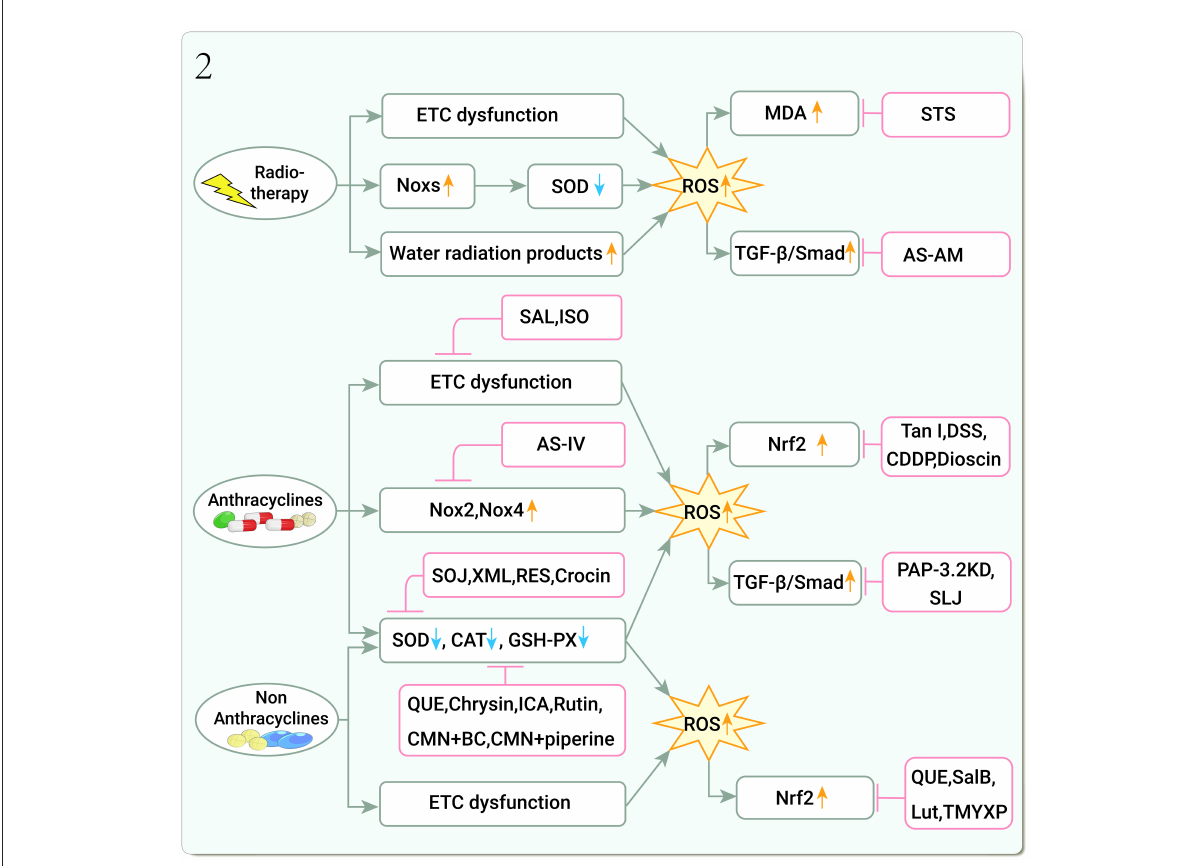
FIGURE2 Traditional Chinese medicine alleviates cardiotoxicity associated with chemoradiotherapy by inhibiting oxidative stress (Noxs, NADPH oxidases; SOD, Superoxide dismutase; CAT, Catalase; GSH-PX, Glutathione peroxidase; ROS, Reactive oxygen species; MDA, Malondialdehyde; TGF- β , Transforming growth factor- β ; Smad, Small Mothers Against Decapentaplegic; Nrf2, Nuclear factor erythroid 2-related factor 2; STS, Tanshinone IIa sodium sulfonate; AS-AM, Angelica Sinensis and Astragalus membranaceus Bunge Ultrafiltration Extract; SAL, Salidroside; ISO, Isoorientin; AS-IV, Astragaloside IV; SOJ, Steroidal saponins extract from Ophiopogon japonicus (SOJ) root; XML, Xinmailong injection; RES, Resveratrol; QUE, Quercetin; ICA, Icariin; CMN, Curcumin; BC, β -carotene; Tan I, Tanshinone I; DSS, Danshensu; CDDP, Compound Danshen Dripping